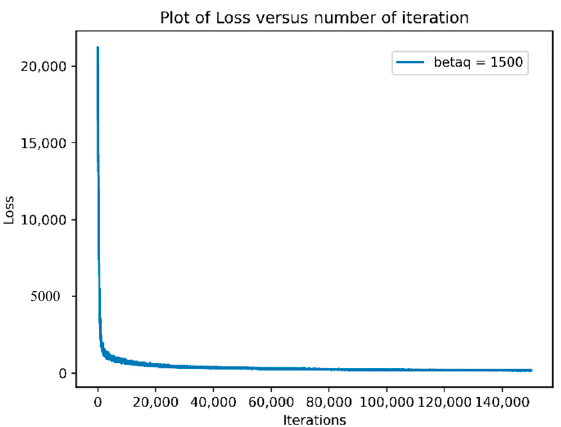
Figure 10. Behavior of the total model loss at various iterations during the training process (trained on weighted Euclidean loss with 150,000 iterations).